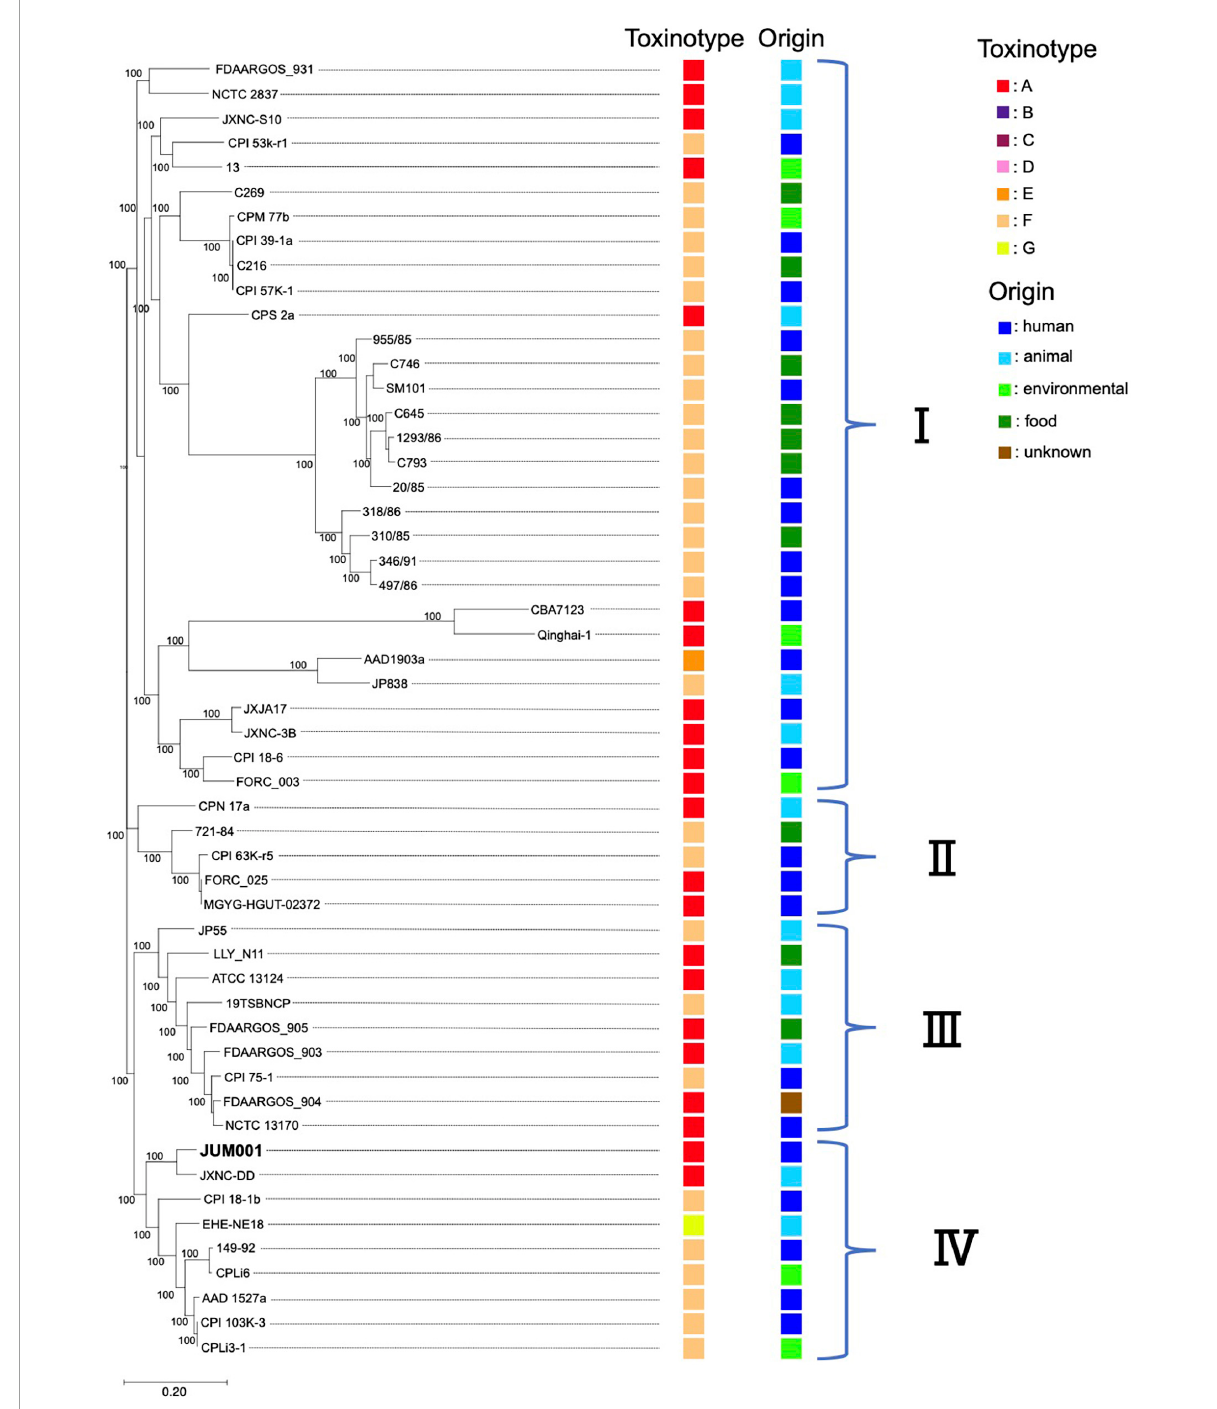
FIGURE4 Phylogenetic tree of C. perfringens JUM001 and 52 previously described C. perfringens strains. The maximum-likelihood phylogenetic using pangenome SNPs among the 53 strains. The toxinotype and origin of isolation of each of these strains are also